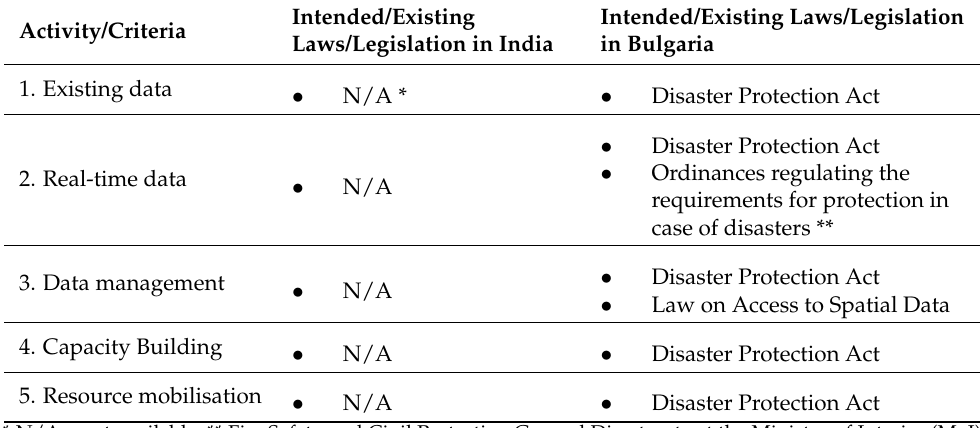
Table 3. Comparativegeospatialdata/informationcontentaccordingtothelegalbasesofIndiaandBulgaria.